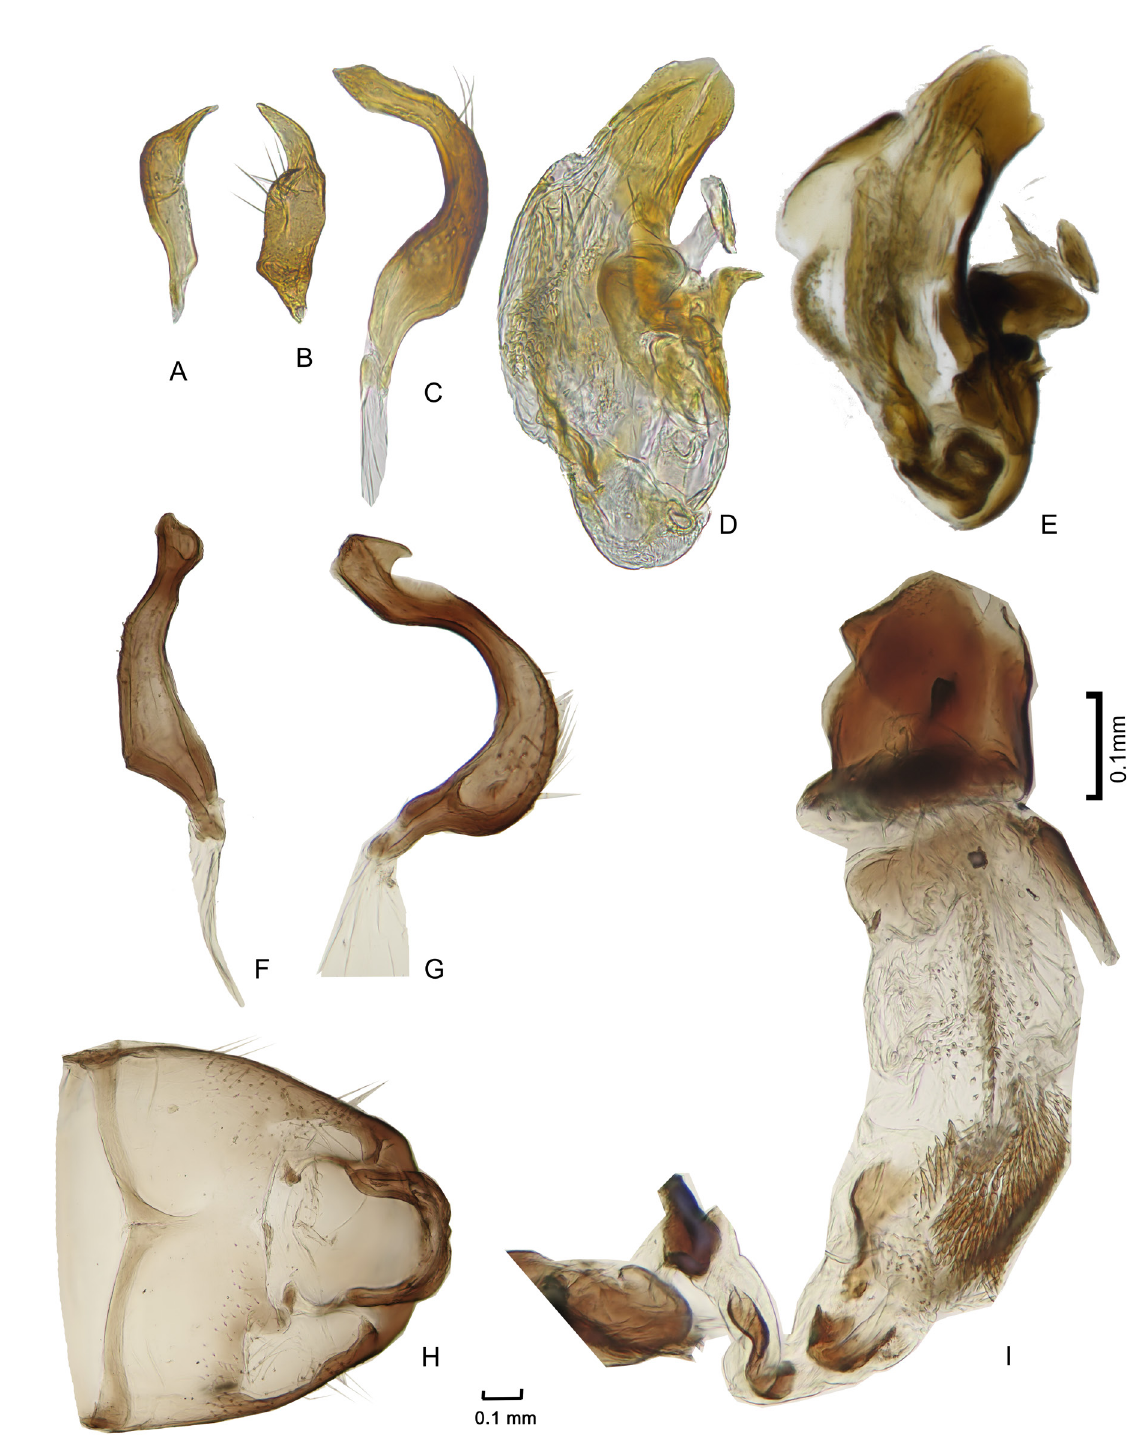
Fig. 11. Male genitalia of Dioclerus spp. A–E . Dioclerus lutheri Stonedahl, 1988, UASB. A–B . Right paramere in dorsal and lateral views C . Left paramere in dorsal view. D . Aedeagus of specimen from Tamil Nadu in lateral view. E . Aedeagus of the holotype in lateral view. F–I . Dioclerus malayensis, Stonedahl, 1988, holotype, AMNH_PBI 00340385, NHM. F . Right paramere in dorsal view. G . Left paramere in lateral view. H . Genital capsule in dorsal view. I . Aedeagus with basal part of phallotheca detached from the phalobase and expanded endosomal